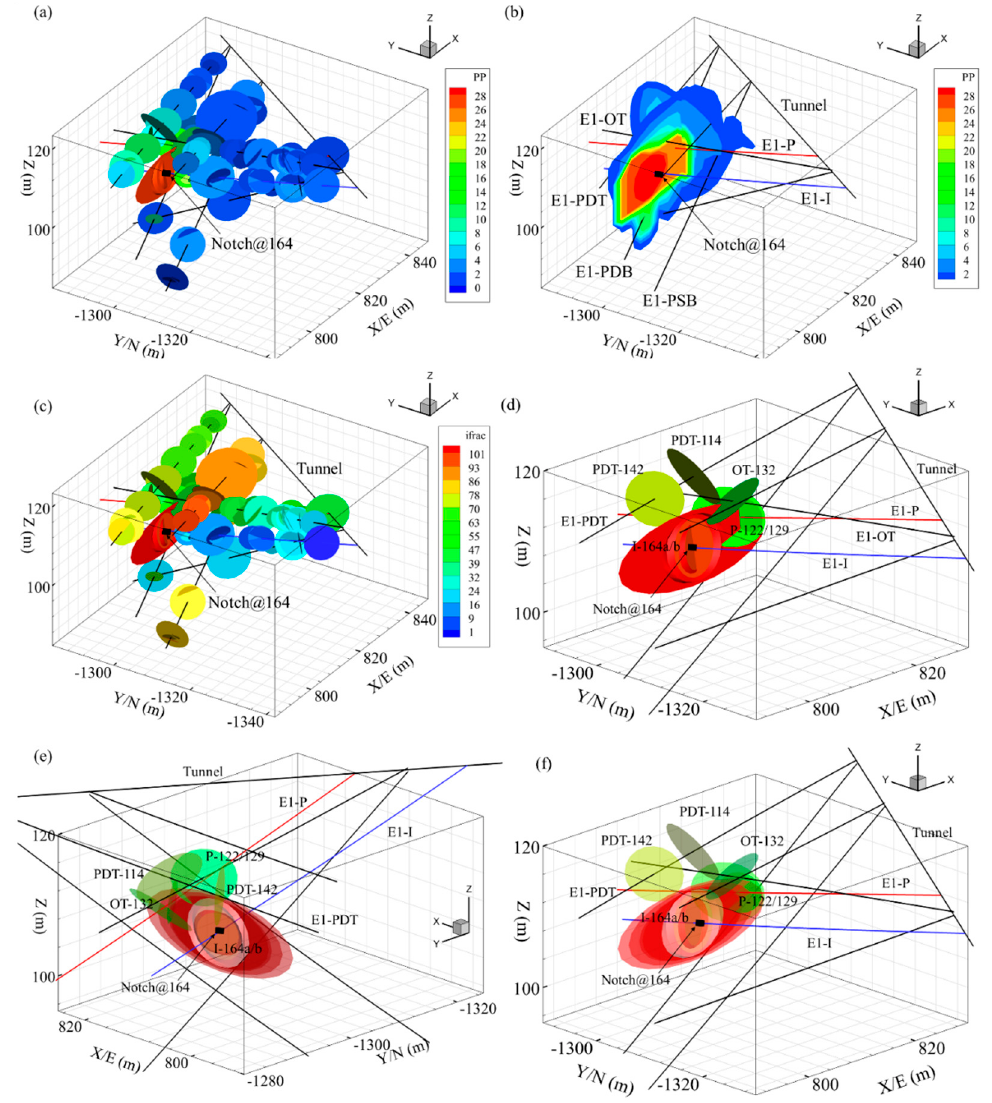
Figure 14. The results from numerical simulation: ( a , b ) show the fracture and matrix pressure at T22:52; ( c , d ) is the propagation of I-164b at T22:52. I-164b fully intersects OT-132, P-122/126/127/129 and E1-P. Injection well E1-I fully connects with production well E1-P. ( e , f ) are transparent views of the fracture network. Unit: MPa.